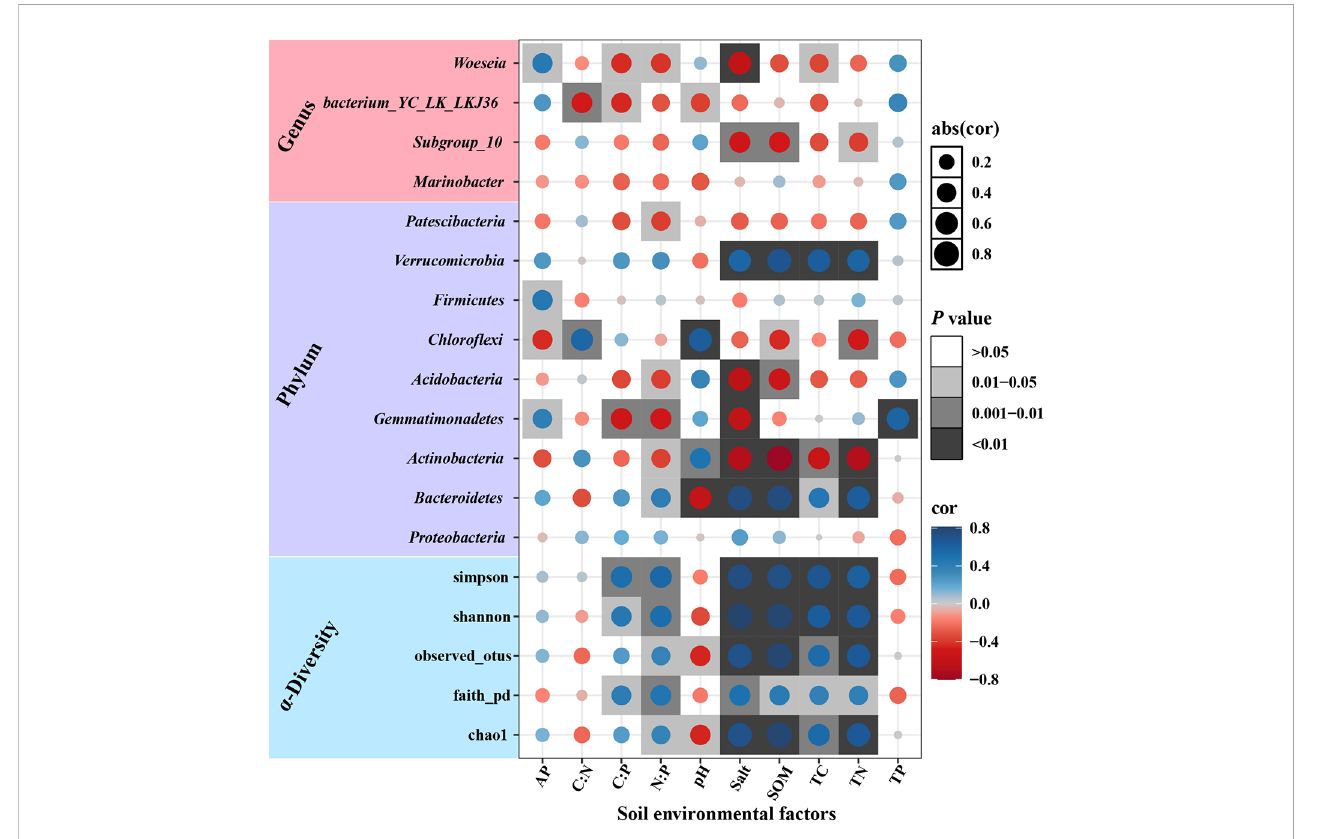
FIGURE 7 The correlation between community and the environmental factors.